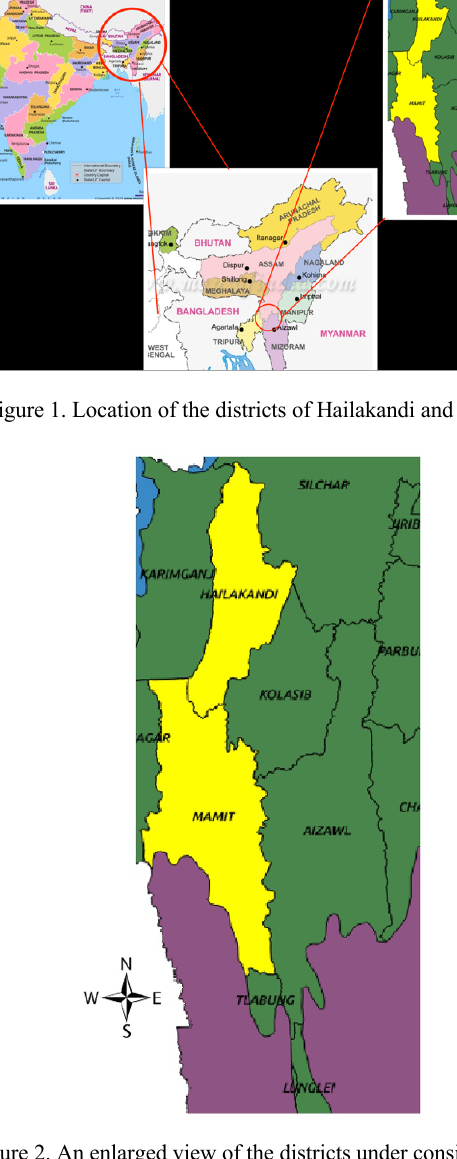
Figure 2. An enlarged view of the districts under consideration (highlighted